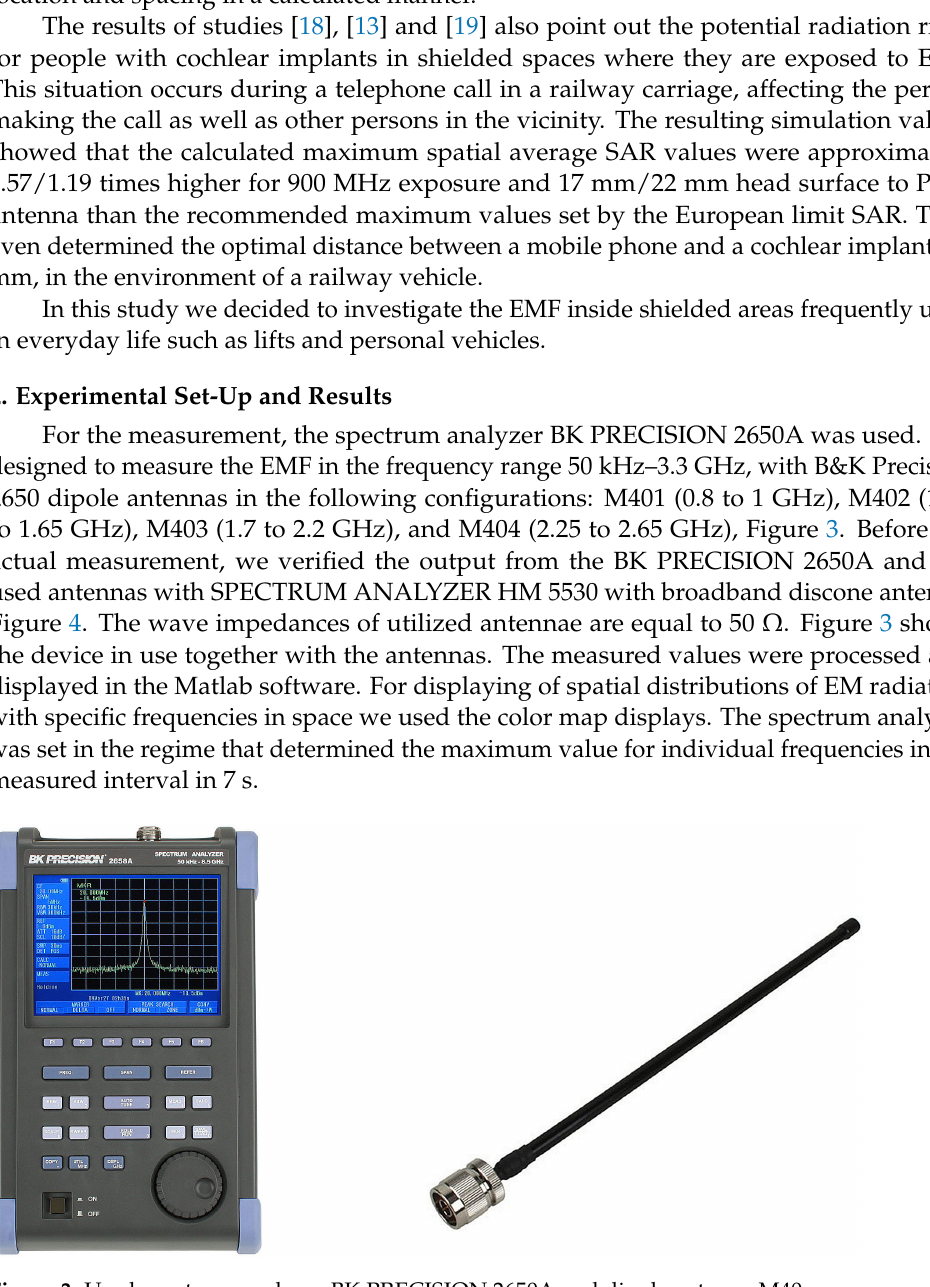
Figure 3. Used spectrum analyzer BK PRECISION 2650A and dipole antenna M40x.